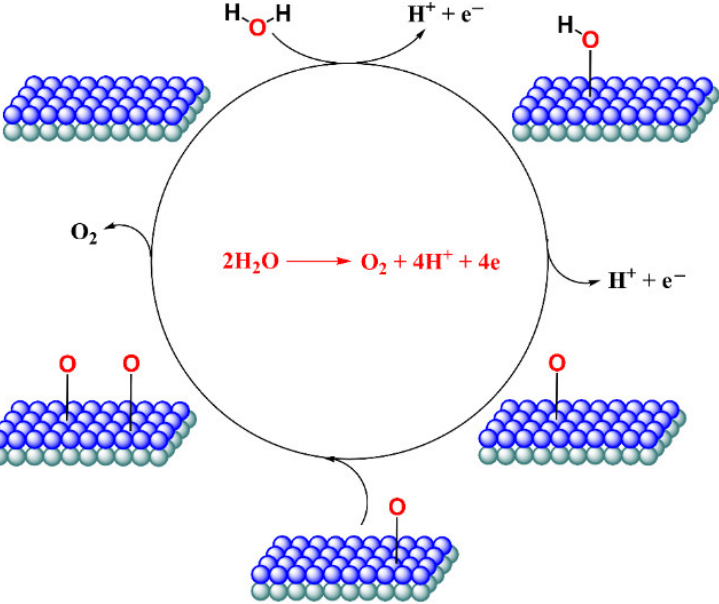
Figure 1. Mechanism of heterogeneous water oxidation in acidic condition. Motivated from ref. [70] and Wikipedia (https://en.wikipedia.org/wiki/Heterogeneous_water_oxidation#cite_note-Birss1-5 (accessed on 4 September 2022)).